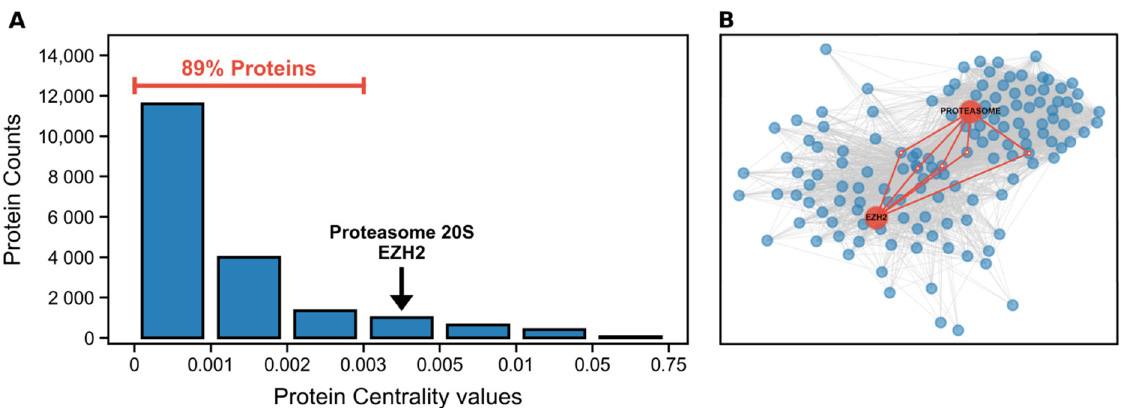
Figure 1. ( A ) Distribution of centralities across the whole human proteome, highlighting the bin containing P20S and EZH2; and ( B ) protein signaling network of EZH2, P20S, and all the signaling paths that connect them, with a maximum length of 4 (i.e., 2 intermediate nodes between the two target proteins). This plot contains a total of 1063 paths and 139 proteins. The blue points represent neighbours of EZH2 and P20S, grey lines indicate signaling relationships between proteins, and red lines highlight connections to immediate neighbours shared by the two key proteins.